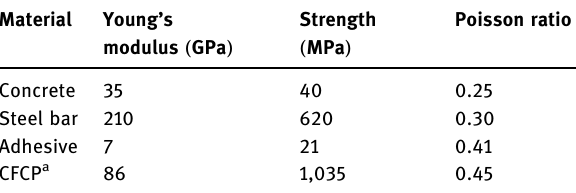
Table 2: Properties of the materials used [ 10 ]